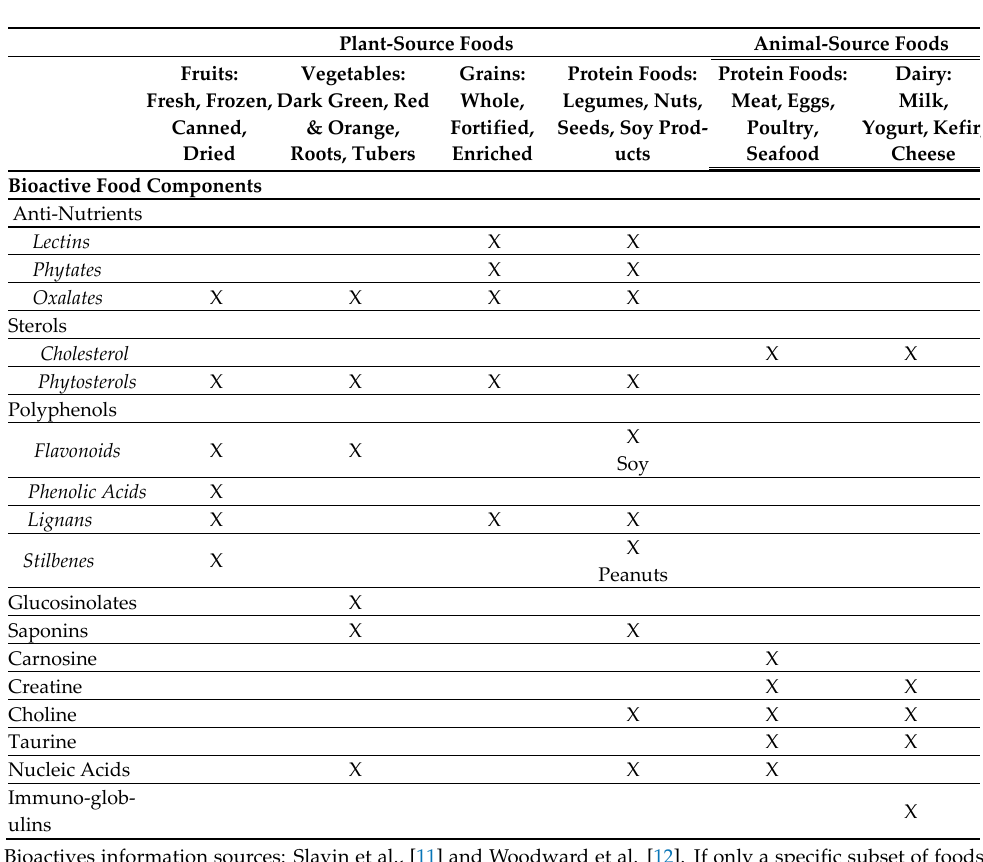
Table 3. Bioactive Food Components Commonly Associated with Plant-Source and Animal- Source Foods.